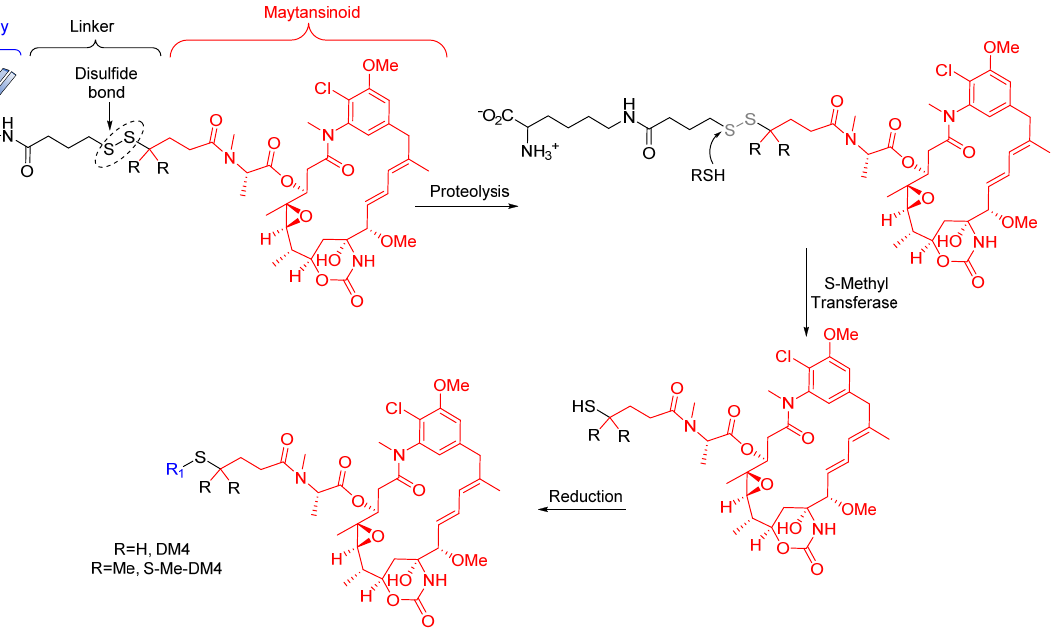
Figure 6. Cleavage mode of disulfide linker in huC242-SPDB-DM4. The ADC loses antibodies by proteolysis and then undergoes disulfide bond cleavage to form the active drug. The drug is then metabolized with S methyl transferase.